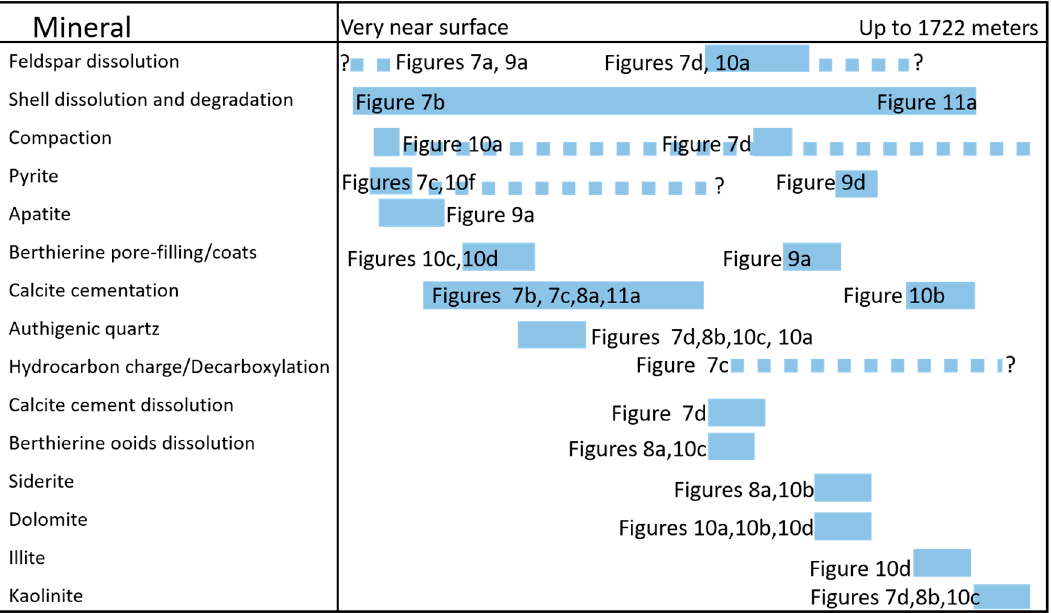
Figure 16. Paragenetic sequence for the Corallian sandstones showing the sequence of diagenetic events. The sequence shows eogenetic events as the rocks have not been buried to more than about 1722 m and not exceeded about 60 ◦ C (Figure 15a). The source of the evidence behind each interpreted step in the paragenetic sequence is listed in the figure. Evidence for the paragenetic sequence include K-feldspar dissolution (Figures 7a,d, 9a and 10a), shell dissolution and shell degradation (Figures 7b and 11a), compaction (Figure 10a), pyrite (Figures 7b, 8d and 10f), apatite (Figure 9a), berthierine pore-filling/coats (Figures 9a and 10c), calcite cementation (Figure 7b,c, Figures 8a and 11a), quartz overgrowth (Figure 10c,d), hydrocarbon charge (Figure 7d), calcite dissolution (Figure 7d), Fe-ooids dissolution Figures 8a and 10c), siderite (Figures 8a and 10b), dolomite (Figure 10a,b,d), illite (Figure 10d), kaolinite (Figures 7d, 8b and 10c).